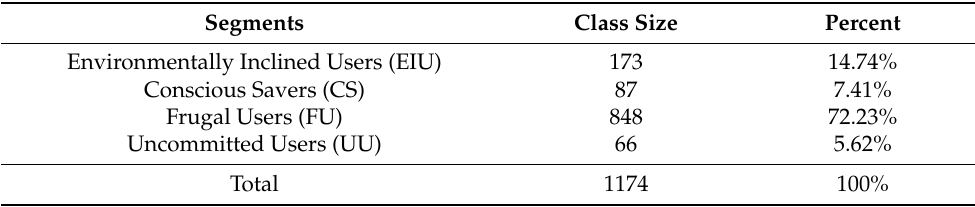
Table 2. Class size of individual electricity consumer